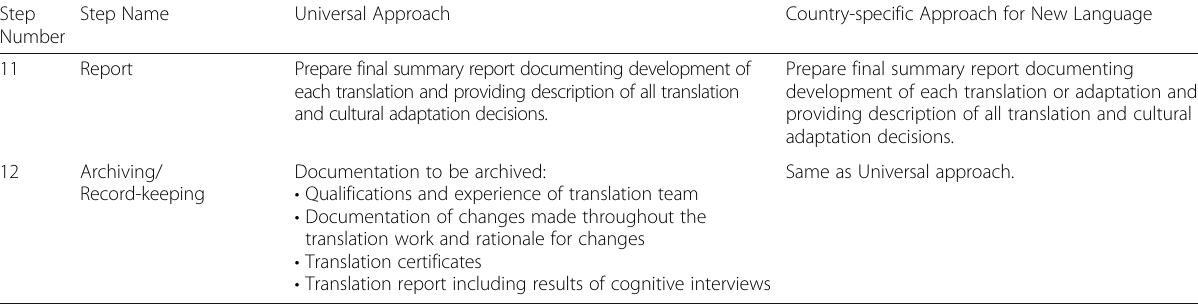
Table 3 PRO Consortium Translation Process Steps